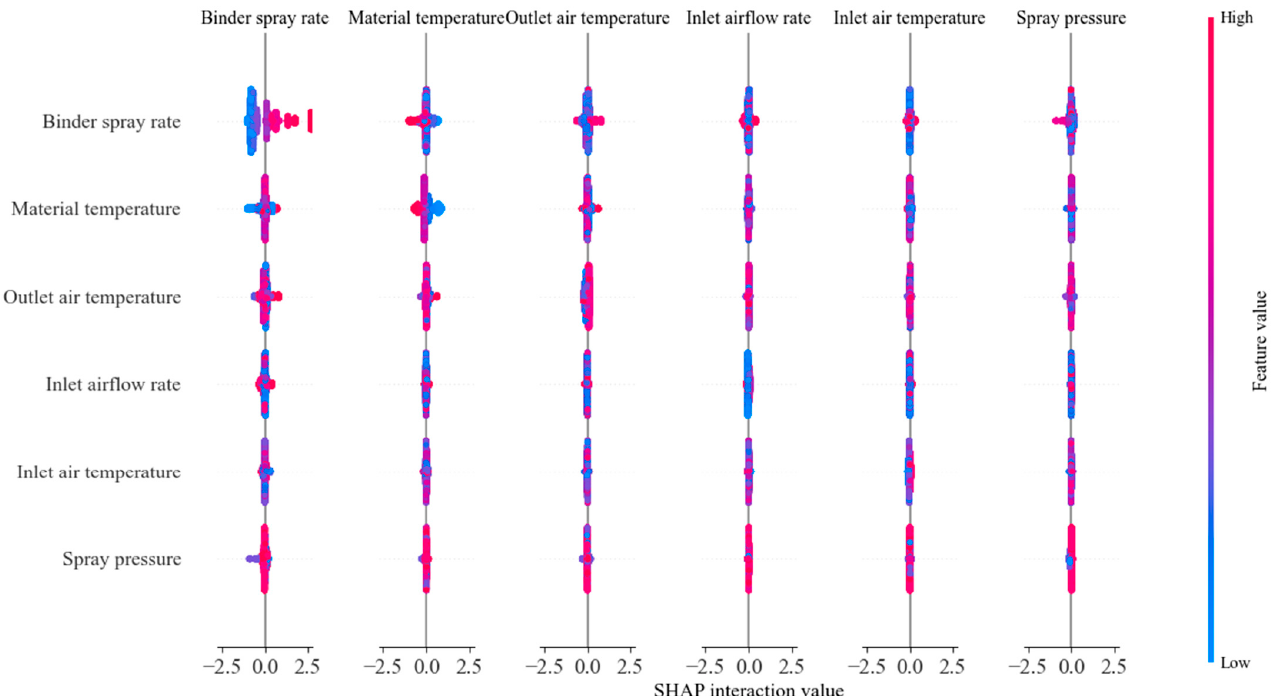
Figure 3. Summary plot for the SHapley Additive exPlanations (SHAP) interaction values of the light gradient boosting machine (LightGBM) model.